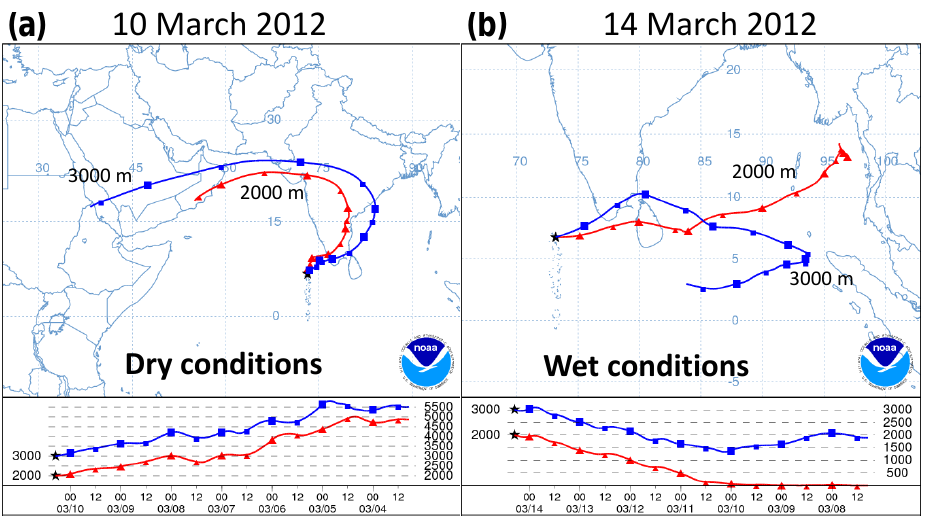
Figure 5. NOAA HYSPLIT 7-day back trajectories arriving at 07:00UTC (12:00MVT) for (a) 10 March 2012, a typical dry day, and (b) 14 March 2012, a typical wet day. Visualization from the HYSPLIT-WEB tool (http://ready.arl.noaa.gov/HYSPLIT.php).